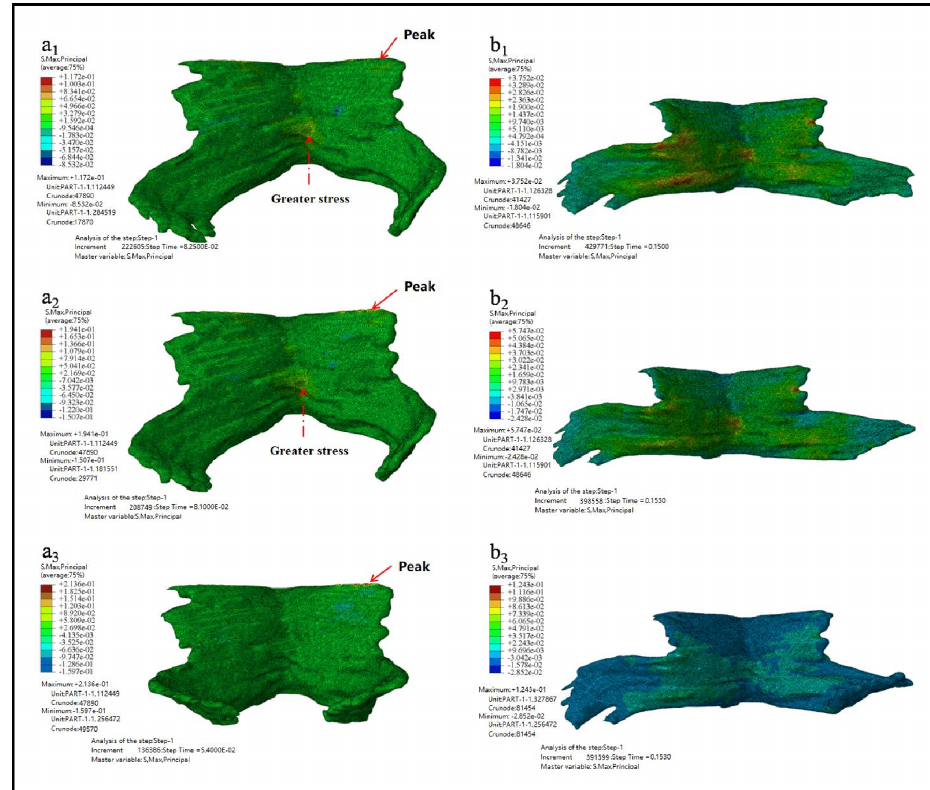
Figure 7. The maximum principal stress nephogram. (a1–a3 showed the maximum principal stress nephogram of Models D80, D90 and D100 while b1–b3 showed the principal stress nephogram of Models D80, D90, and D100 at the nephogram of Models D80, D90 and D100 while b1 – b3 showed the principal stress nephogram of simulation time of 0.15s) Models D80, D90, and D100 at the simulation time of 0.15 s).